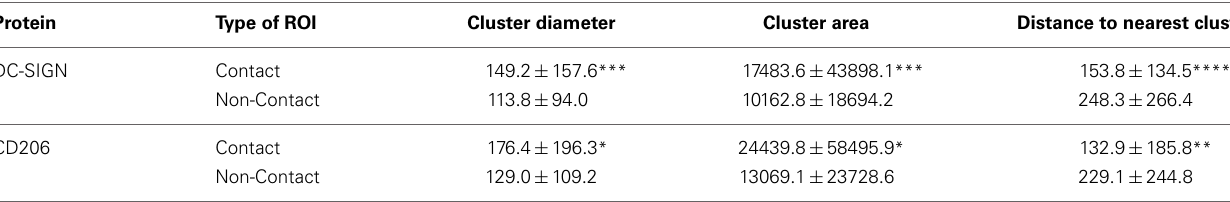
Table 1 | Getis statistical analysis of clustering and local density in fungal contact regions on dendritic cells.